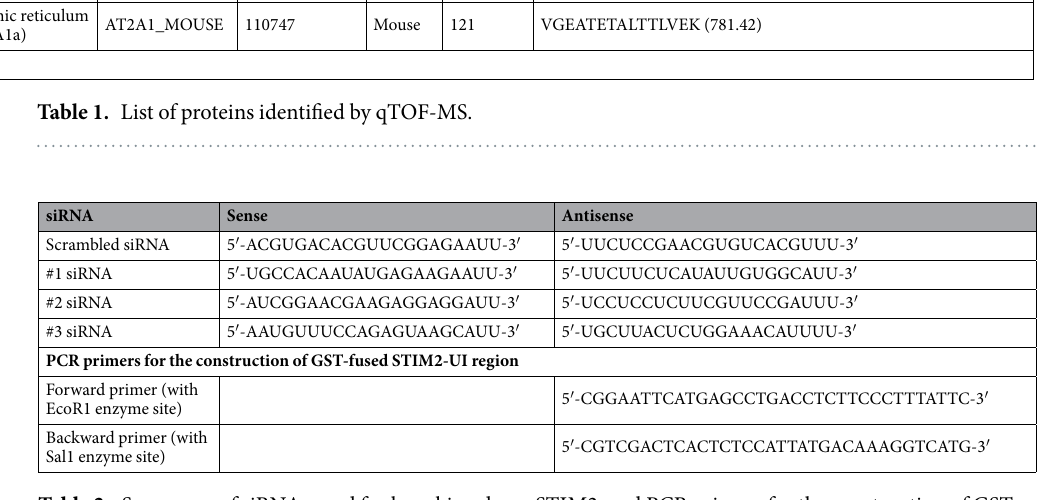
Table 2. Sequences of siRNAs used for knocking down STIM2, and PCR primers for the construction of GST- fused STIM2-UI